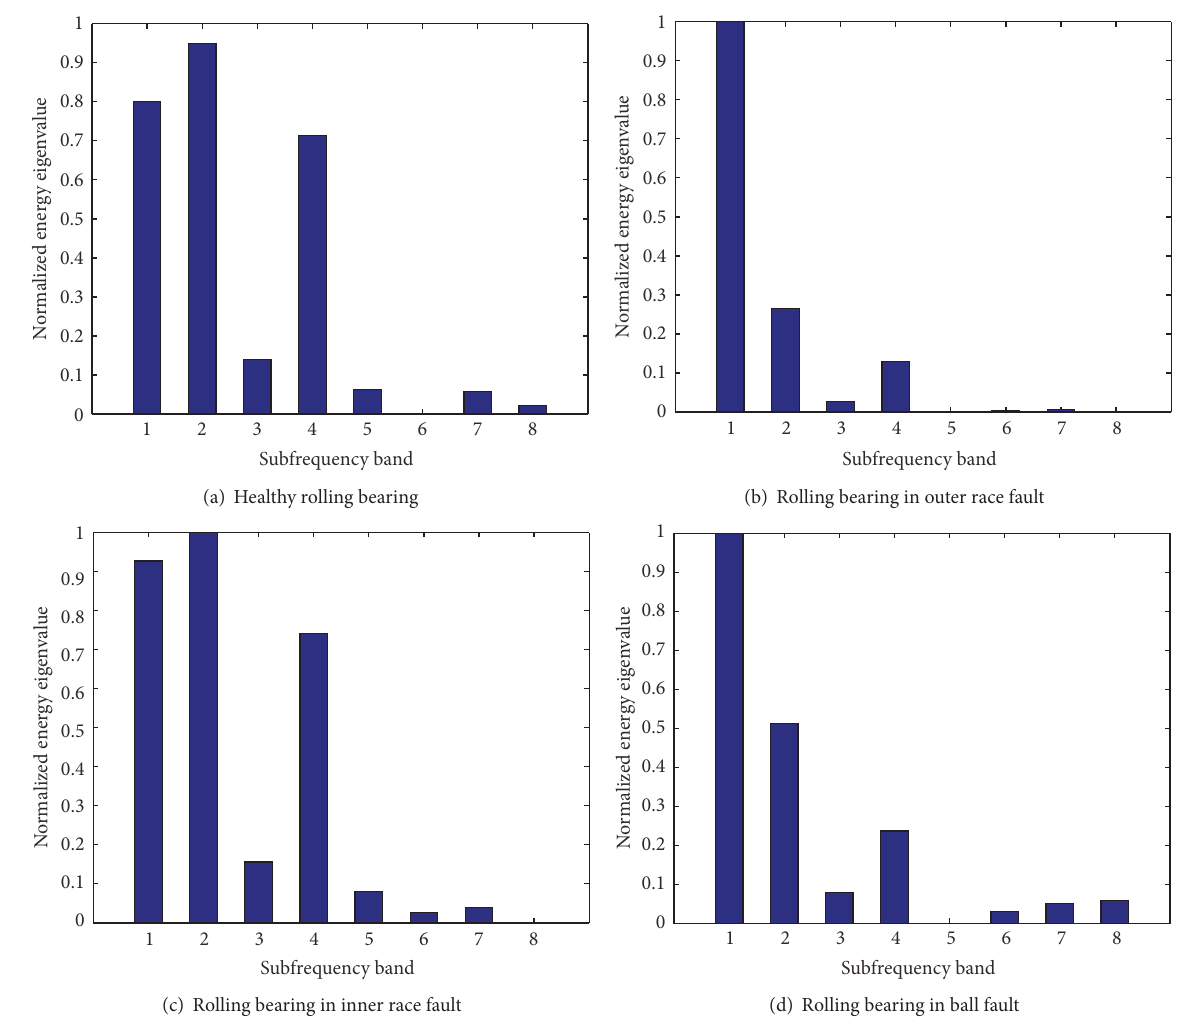
Figure 8: Energy histogram of rolling